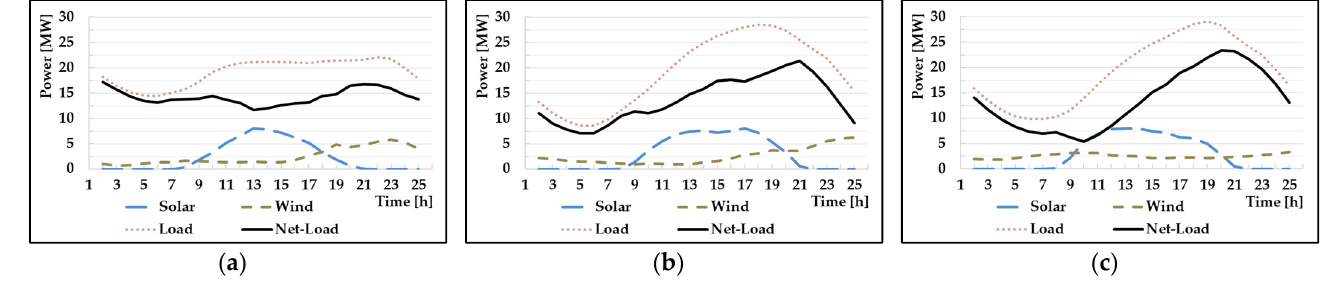
Figure 5. Load and renewable energy generation patterns for scenarios ( a ) A, ( b ) B, and ( c ) C.